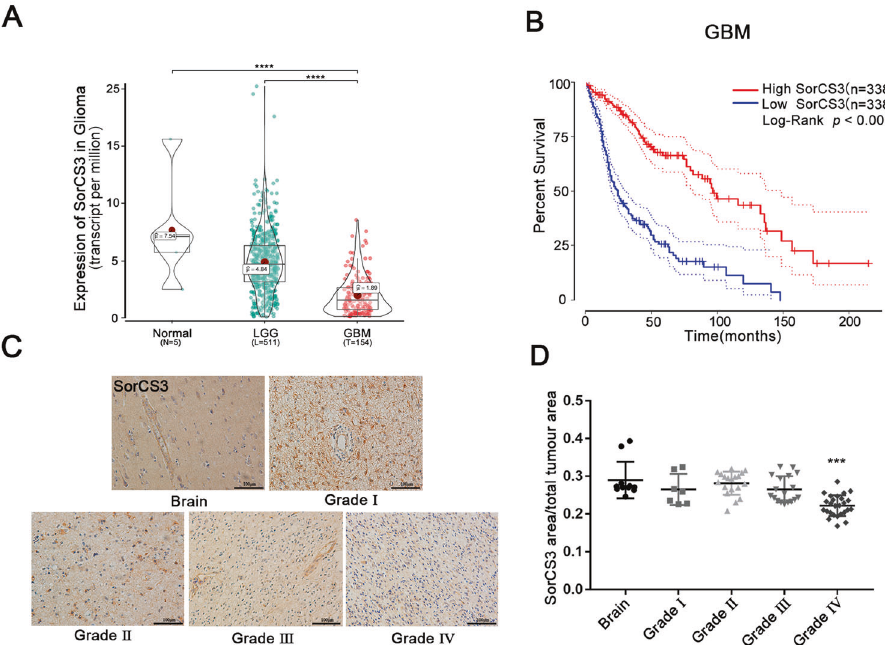
Fig. 1 Overview of SorCS3 expression in TCGA glioma database. A SorCS3 expression level in adjacent normal tissues ( n = 5), low grade glioma tissues ( n = 511) and GBM ( n = 154) in the glioma datasets from TCGA. B Kaplan-Meier Survival curves of different SorCS3 expression levels for GBM in TCGA dataset (High SorCS3, n = 338; Low SorCS3, n = 338; p < 0.001). C , D SorCS3 expression with different WHO grade glioma and normal brain tissues taken from 108 patients was assessed by IHC. Scale bar: 100 µm. * p < 0.05; ** p < 0.01; *** p < 0.001, ns: not statistically signi fi